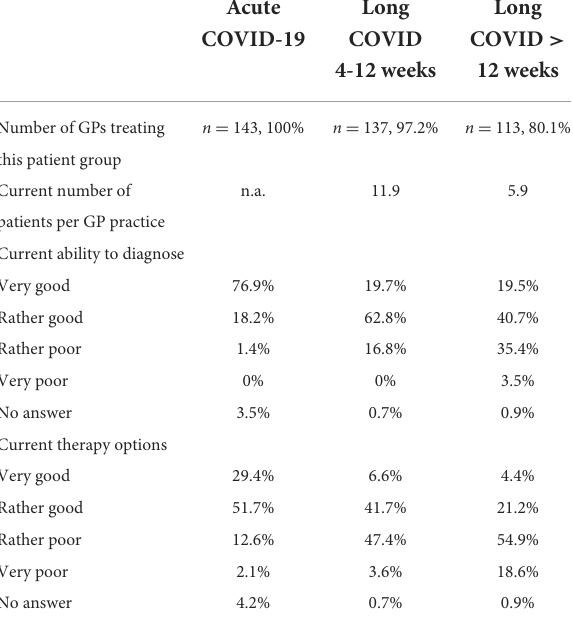
TABLE 1 Number of GPs treating acute COVID-19 and long COVID, number of patients, and ratings of current diagnostic and therapeutic options in GP